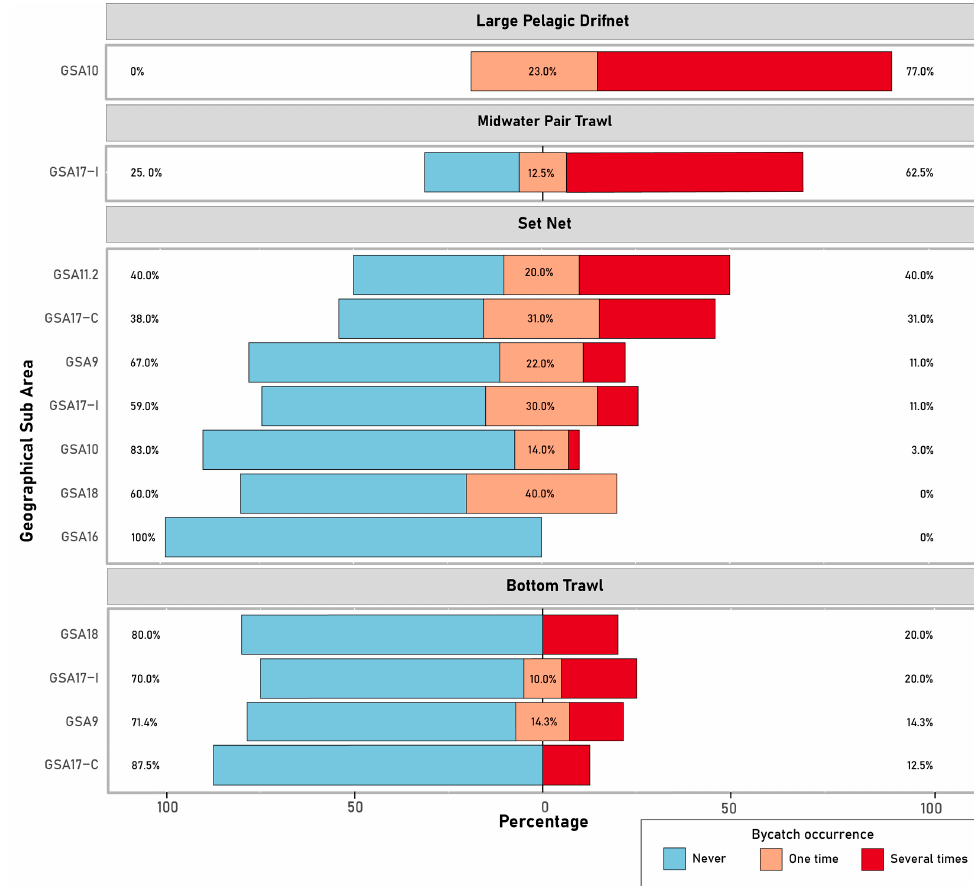
Figure 6. Bycatch occurrence by percentage and organized by Geographical Sub Area (GSA) and type of fishing gear. The barplot represents responses to the questions “Did you ever accidentally catch a dolphin?”, “If yes, which gear was by?”, and “How many times has it happened? (number of bycatch events/years of activity)”.